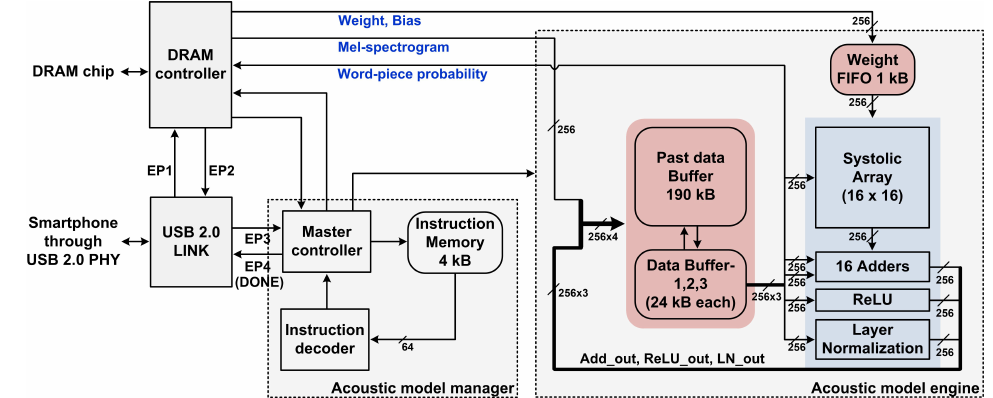
Figure 4. Hardware architecture of proposed